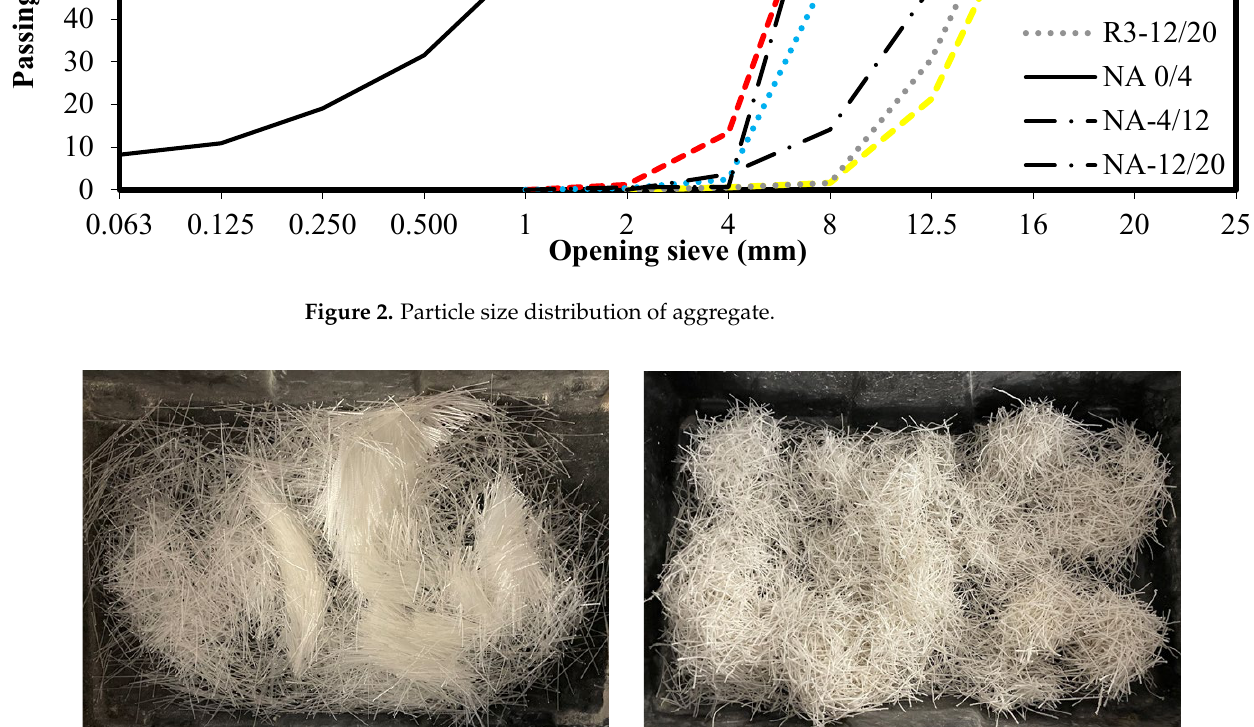
Figure 3. Virgin polypropylene fibers ( left ); recovered polypropylene fibers ( right ).